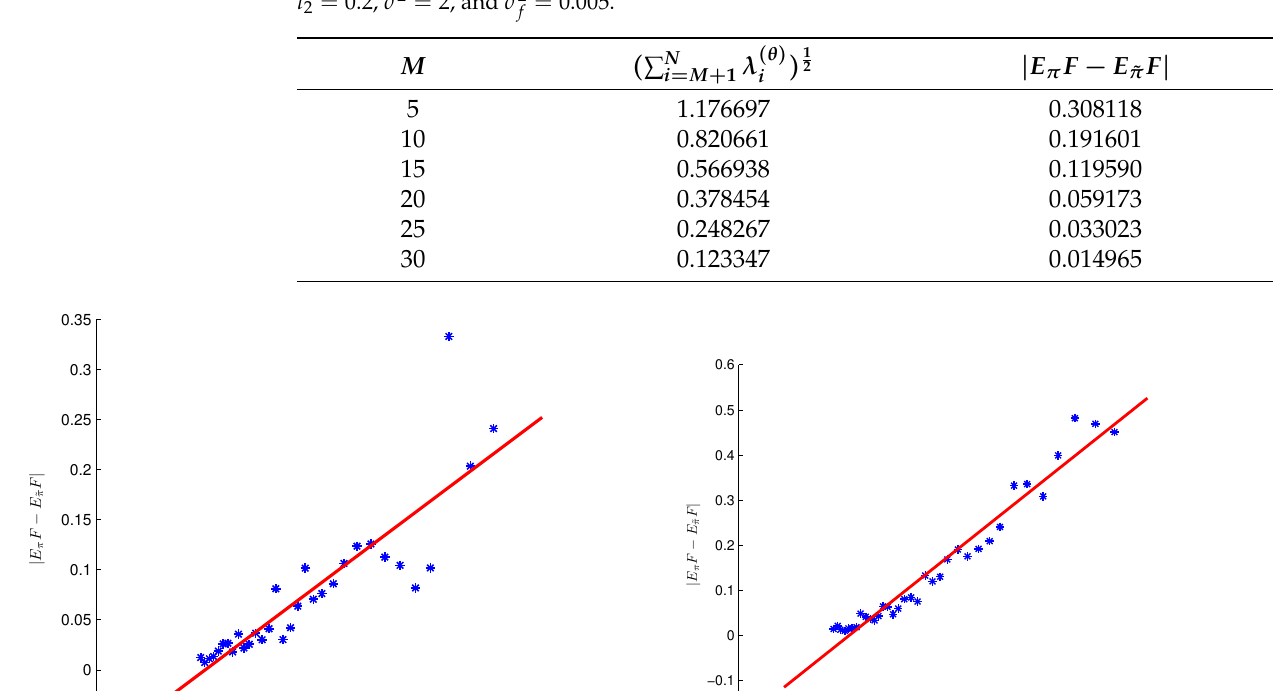
Table 2. Posterior errors l 2 = 0.2, σ 2 = 2, and σ 2